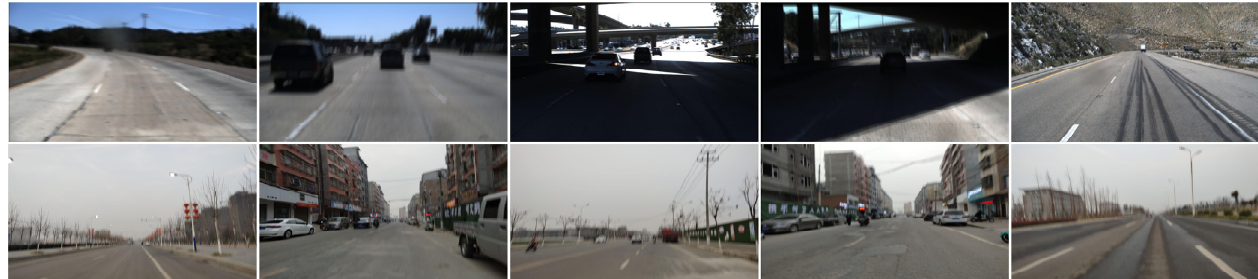
Figure 6. Several examples of blurred images in our dataset.